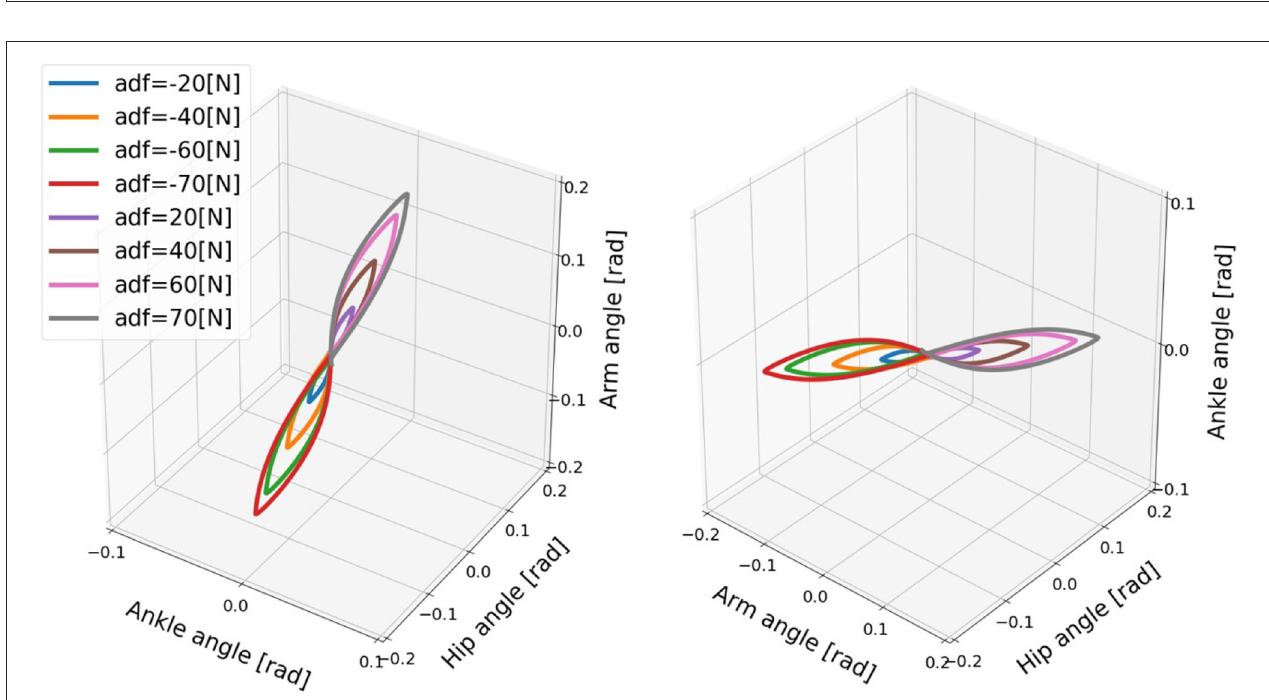
FIGURE 12 | Evolution of the ankle, hip, and arm angles of the model for active arms for different disturbing forces: (1) Push backward: − 20 [ N ], − 40 [ N ], − 60 [ N ], − 70 [ N ]. (2) No force: 0 [ N ]. (3) Push forward: 20 [ N ], 40 [ N ], 60 [ N ], 70 [ N ]. “a” in the label “adf” represents the case with active arms, and “df” represents the disturbing force. The mean joint correlation between ankle and hip is 0.898 and the one between hip and arm is 0.966.